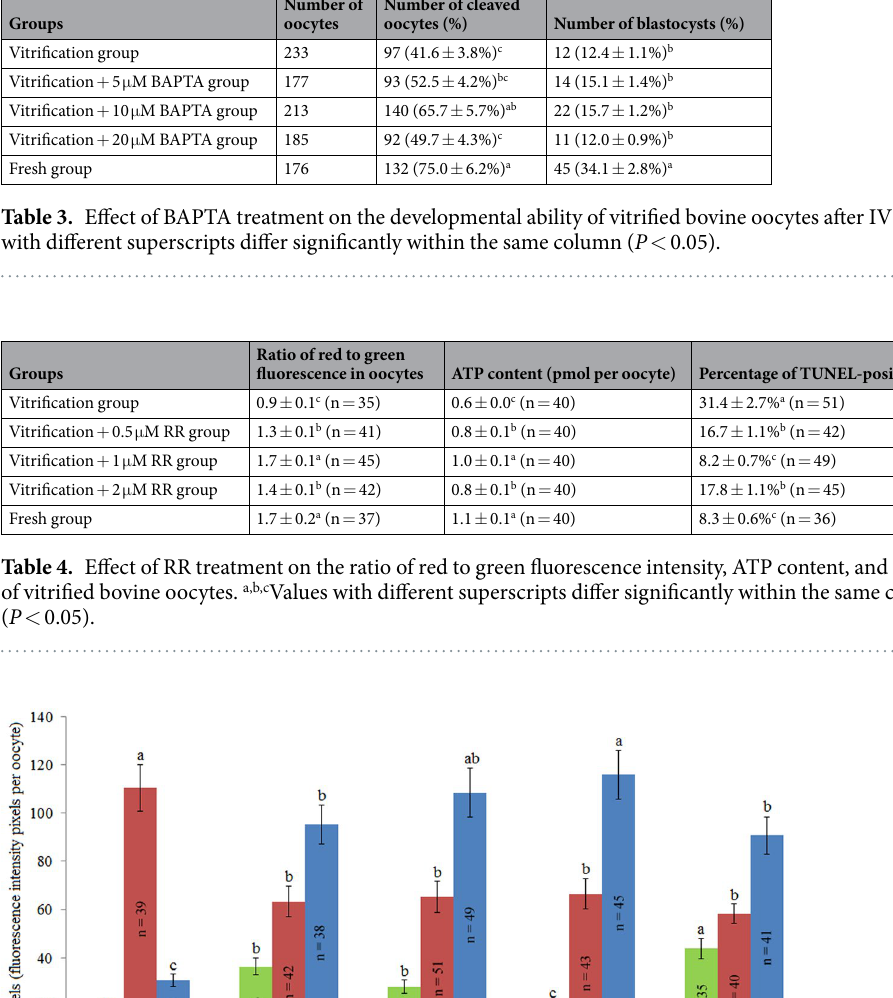
Experiment 4: Effect of BAPTA and RR on the developmental ability of vitrified bovine oocytes after IVF.